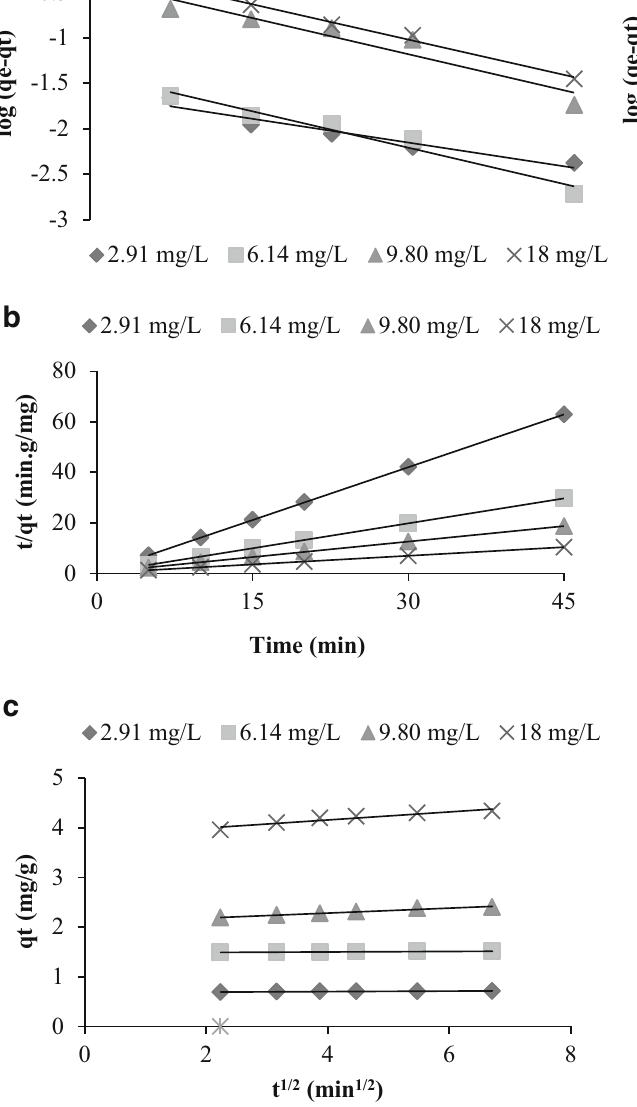
Fig. 7 a Lagergren first-order model when initial concentration was varied. b Pseudo-second-order kinetic model when initial concentra- tion was varied . c Morris–Weber intra-particle diffusion model when initial concentration was varied. d Lagergren first-order model when